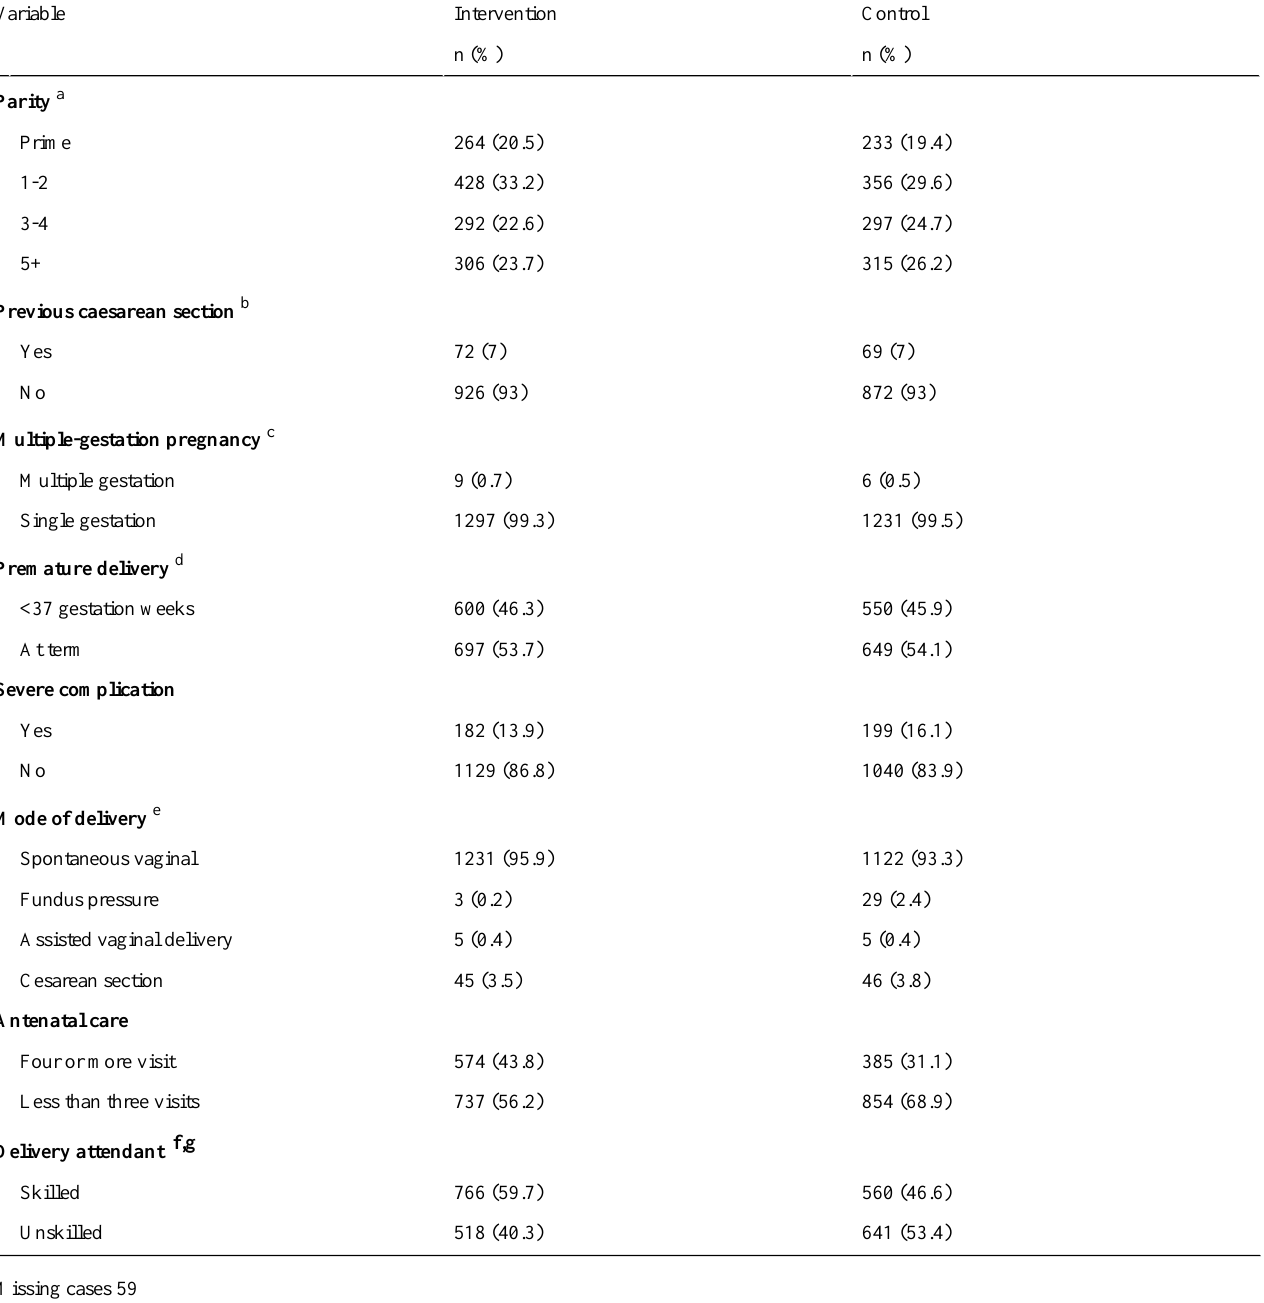
Table 2. Obstetric characteristics of study